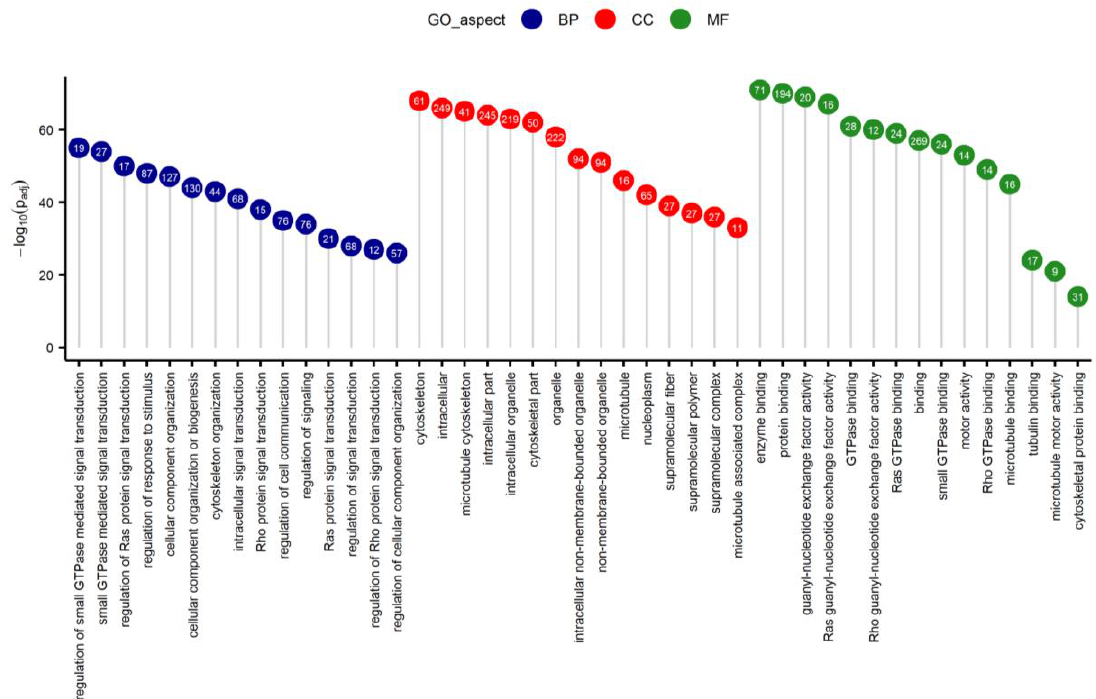
Figure 3. Lollipop chart of the top 15 Gene Ontology (GO) terms for each GO aspect (BP—biological process; CC—cellular components; MF—molecular function), scattered according to −log10 adjusted p -value. Numbers in circles refer to the number of DEGs annotated to the specific GO term.